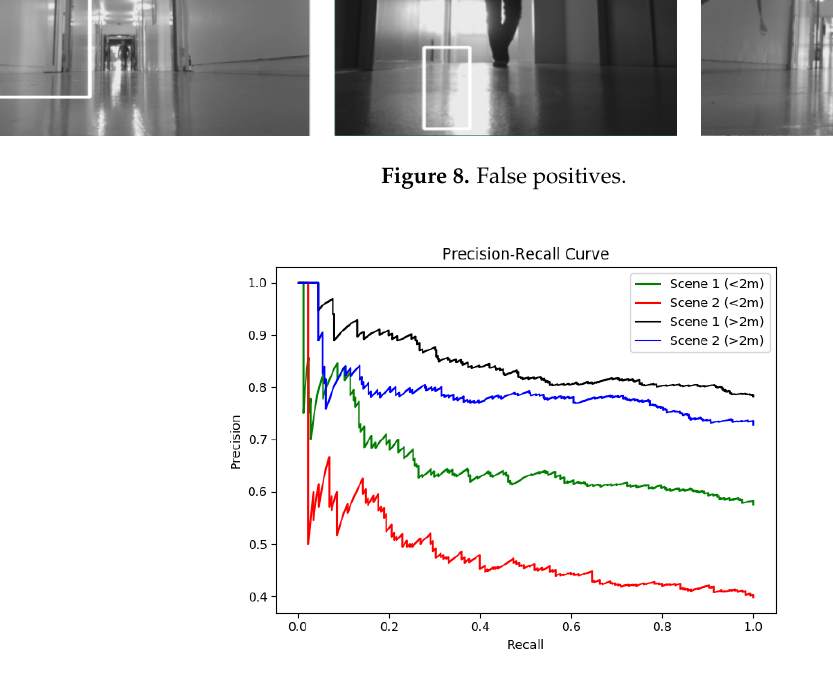
Figure 9. Precision-recall